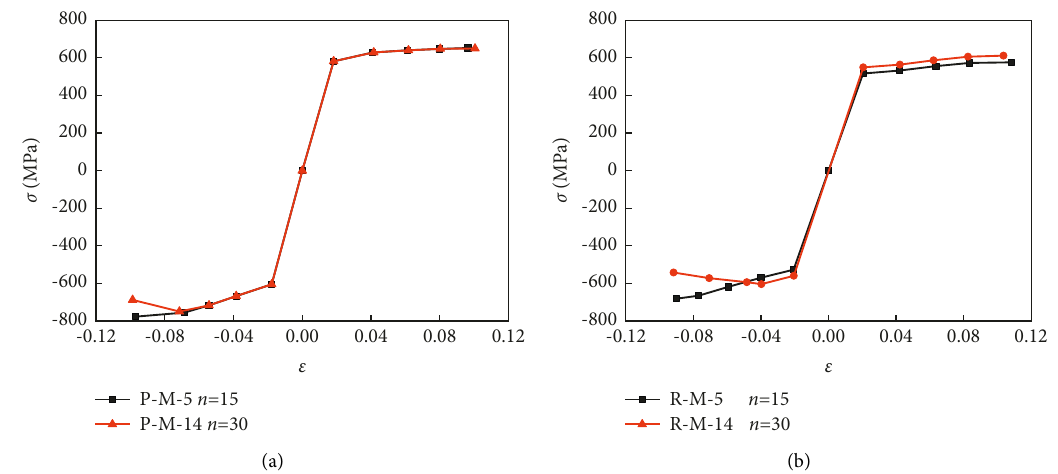
Figure 22: Skeleton curves of material specimens under different loading patterns. (a) Specimens P-M-5 and P-M-14. (b) Specimens R-M-5 and R-M-14.